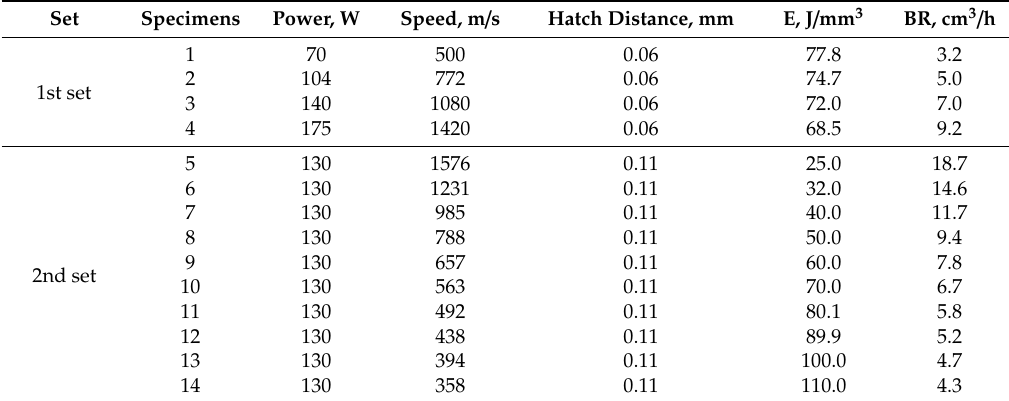
Table 1. Processing parameters for 14 Ti-Zr-Nb calibration specimens (constant layer thickness of t = 30 µ